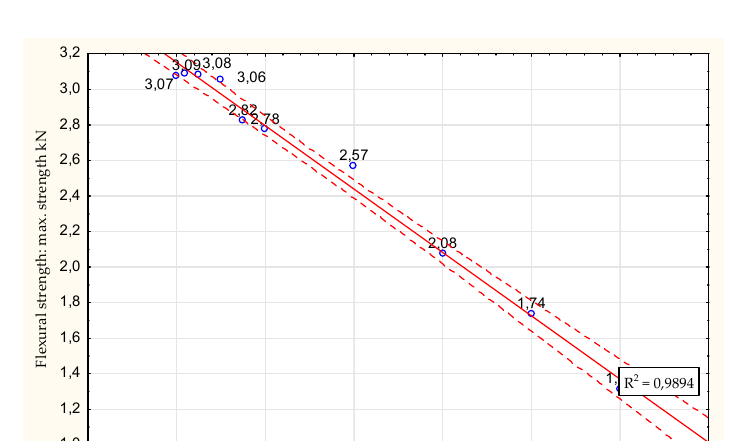
Figure 31. Average values obtained during flexural strength tests after 28 days for water − mix ratio = 0.6, maximal strength.